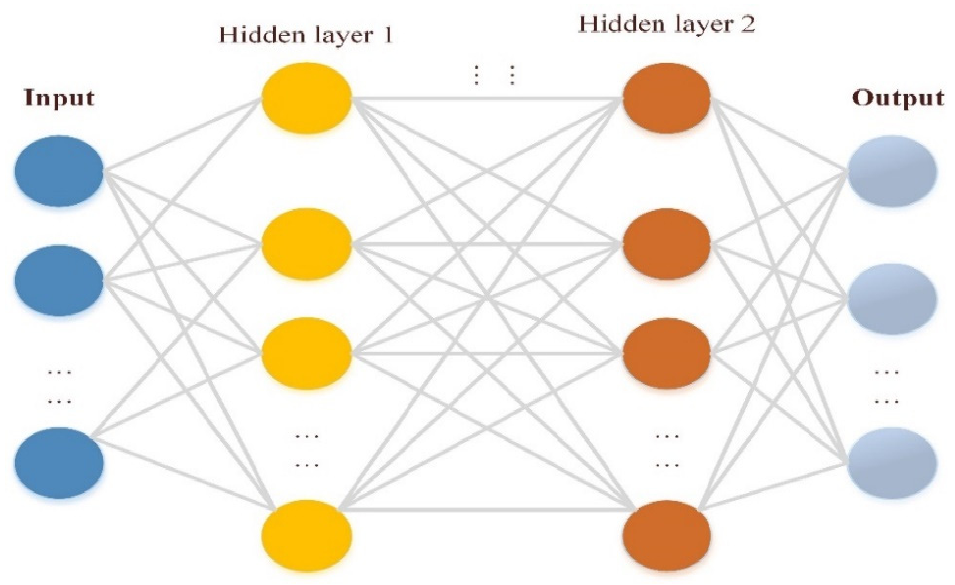
Figure 9. Deep learning technique.